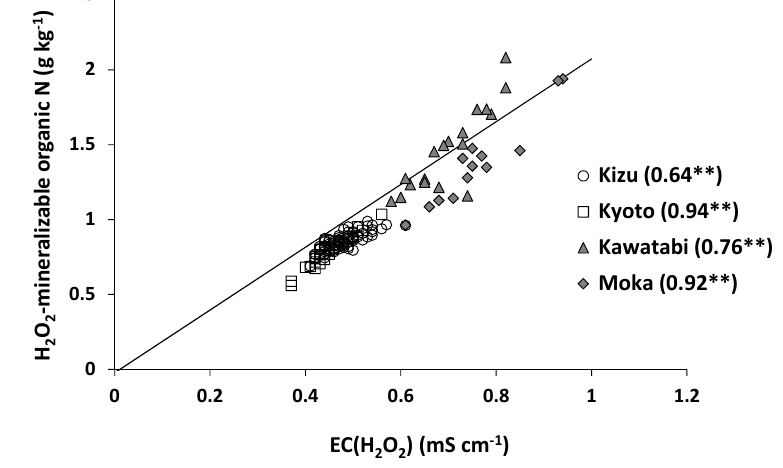
Figure 5. Relationship between EC (H 2 O 2 ) and H 2 O 2 -mineralizable organic N at farm scale. The line in the figure shows the regression line obtained from the nationwide samples ( n = 83) [9]. ** indicates statistical significance of the determination coefficients at p < 0.01.